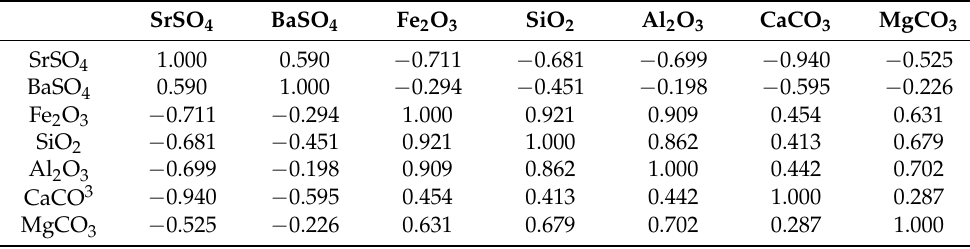
Table 3. Correlation analysis between phase determined by XRF. Significant correlations ( p < 0.05) are in bold